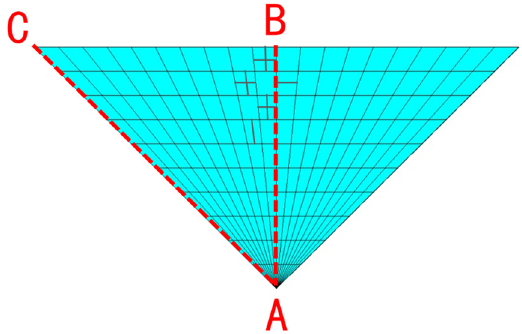
Figure 10. Vertical dam face in a triangular valley.